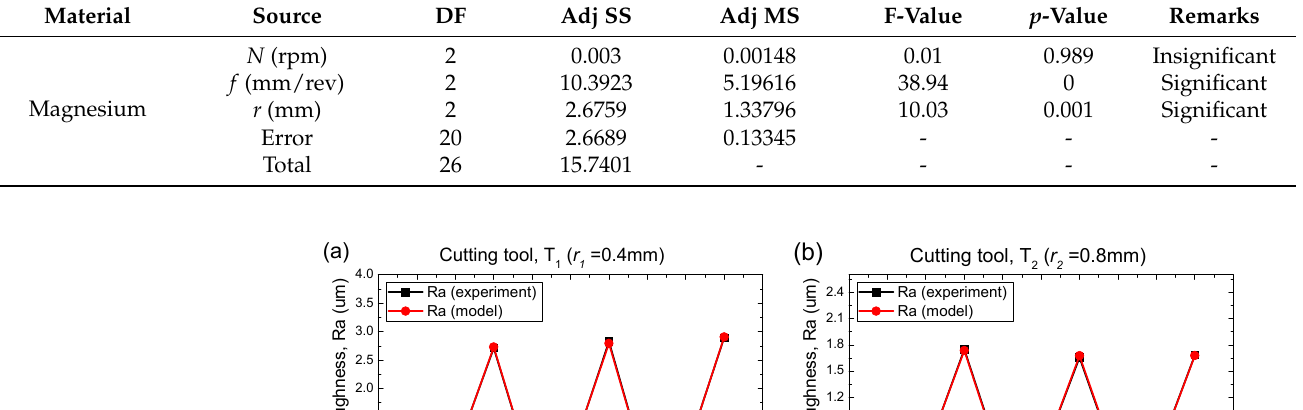
Table 4. ANOVA of surface roughness (R a ) for the combination of cutting parameters N, f, r (CNFR).